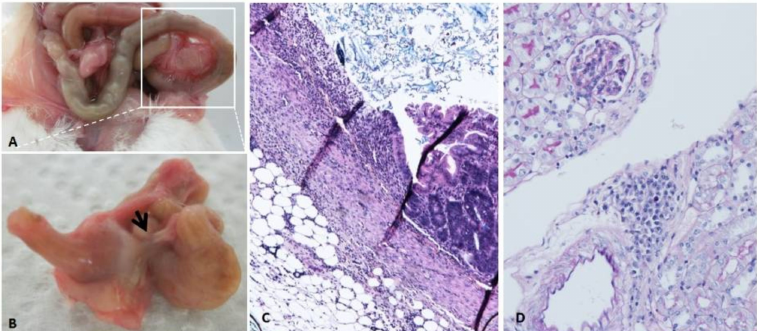
Figure 3. Cisplatin can have long-term effects in the gastrointestinal tract ( A ). A case of penetrating ulcer ( B , arrow and C ) in a mouse that survived a single lethal dose of cisplatin (17 mg/kg). Three months after cisplatin recovery, body weight started to decrease, and the mouse was killed and autopsy performed. Inflammatory cells found in the kidney ( D